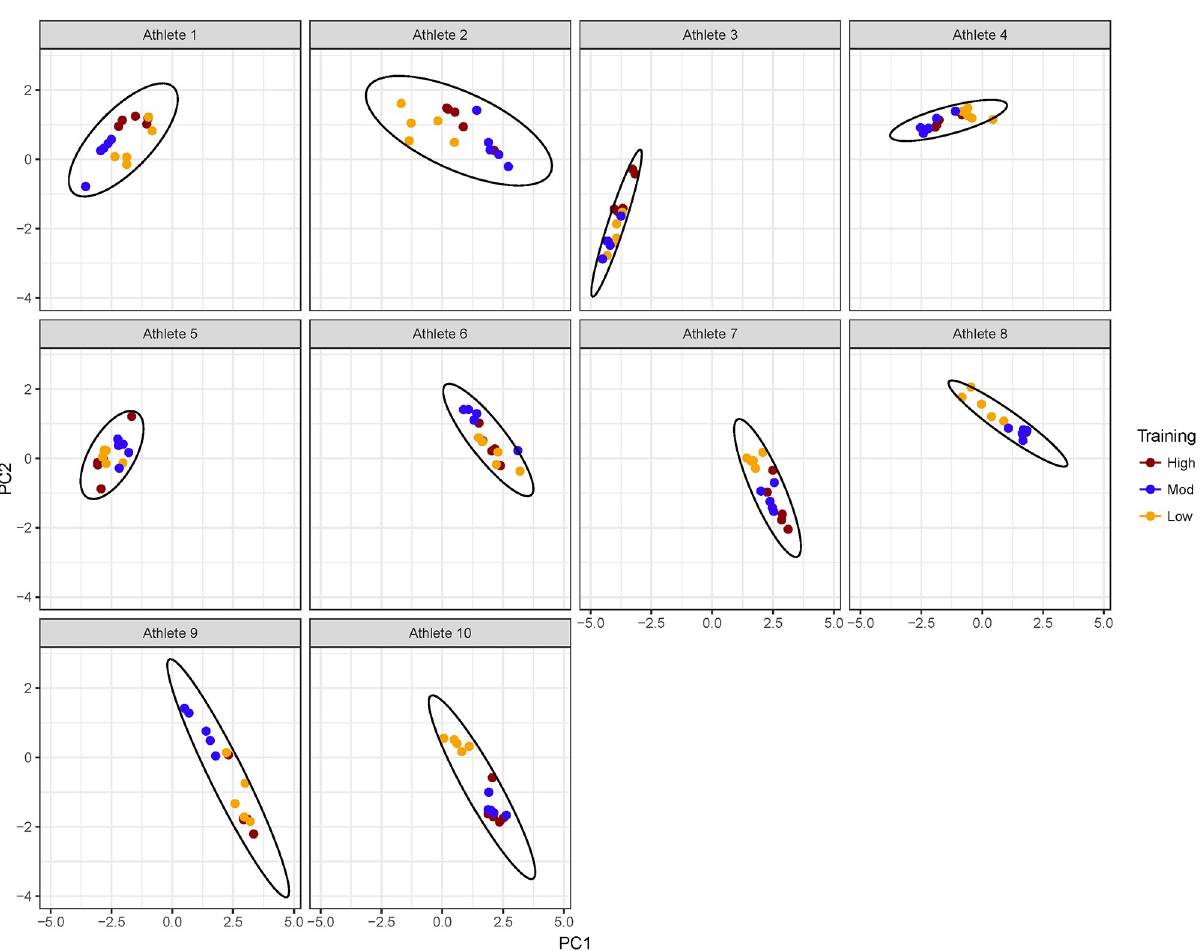
Fig 2. CMJ rel PeakF results plotted against PC1 and PC2, illustrating the grouping of individual athlete results and intra-athlete spread of results according to training session workload. CMJ performance tends to cluster by athlete, and within each athlete, there is some separation by training